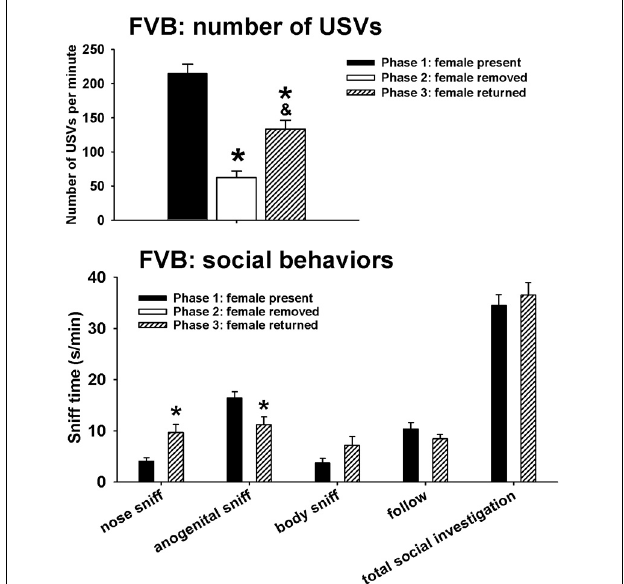
FIGURE 3 | USVs and social behaviors in BTBR males in phases 1, 2, and 3. USVs were detected from 9 out of 11 BTBR in phase 1, 4 out of 11 BTBR in phase 2, and 9 out of 11 BTBR in phase 3. All animals were included in call number analysis and behavioral comparisons. BTBR emitted fewer USVs in phase 2 than in phase 1, and more in phase 3 than in phase 2. Analysis of behavioral parameters revealed no significant differences between phase 1 and phase 3, on durations of anogenital sniffing, body sniffing, follow, and total social investigation. BTBR displayed higher levels of nose-to-nose sniffing in phase 3 than in phase 1. ∗ p < 0 . 05 vs. phase 1; & p < 0 . 05 vs. phase